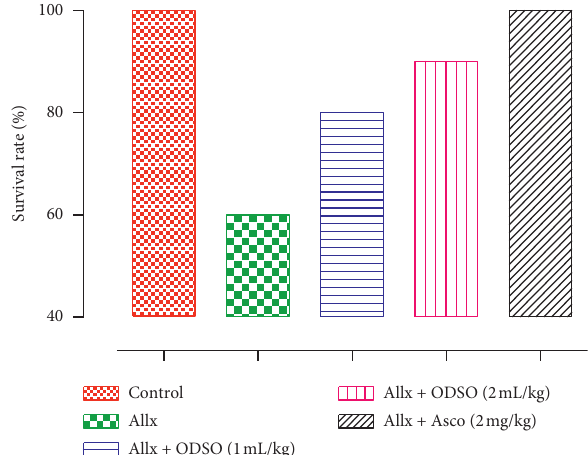
Figure 2: The effect of ODSO and ascorbic acid on the survival rate of Swiss albino mice after Allx administration. n � 10; ODSO, O. dillenii seeds oil; Allx,